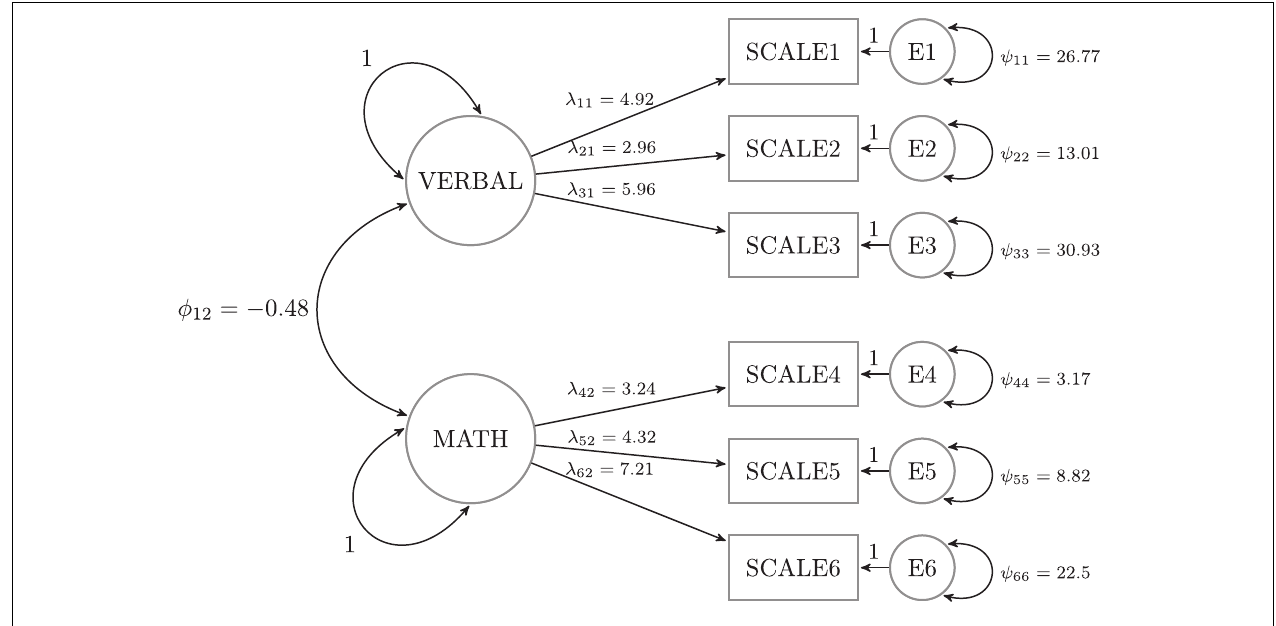
FIGURE 2 | General model used for the